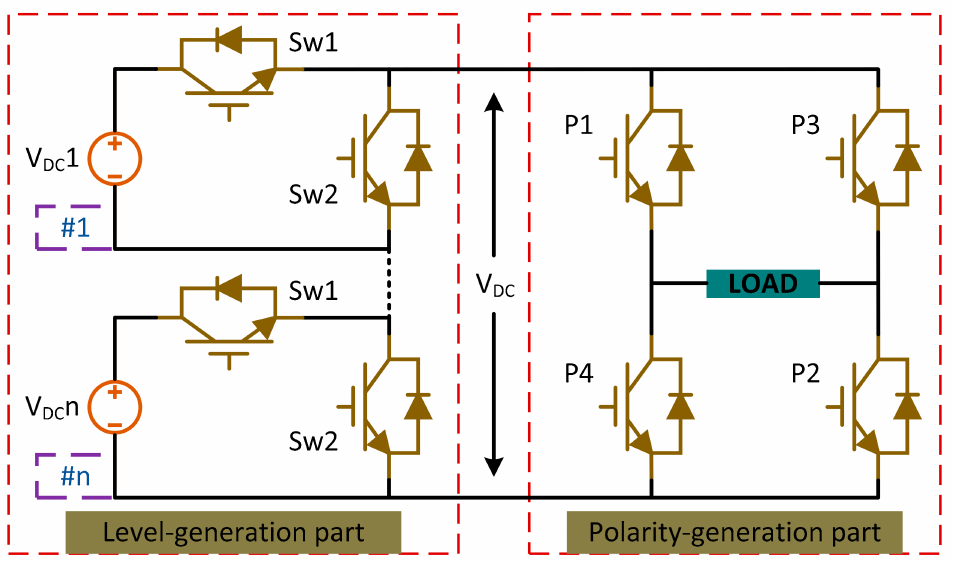
Figure 11. Topology of multiple level dc links inverter.